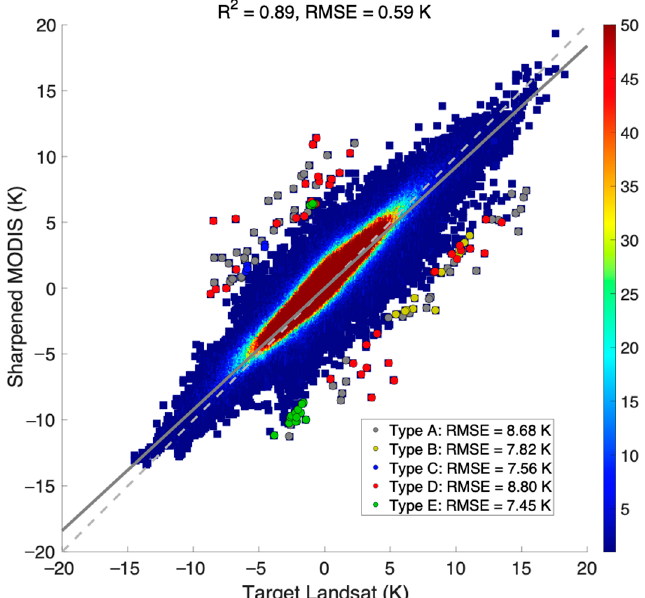
Figure 16. Pixel-by-pixel correlation between sharpened MODIS LST and target Landsat LST for within-patch variations and for all 26 dates. The overall spatial correlation (R 2 ) and RMSE are noted. The color bar indicates data density, presented by number of pixels within each 0.1-K bin. The solid gray line shows the linear fitting function, and the dashed gray line indicates the 1:1 relationship. Pixels of absolute biases of 7 K or more are marked in different colors depending on the types of land use.